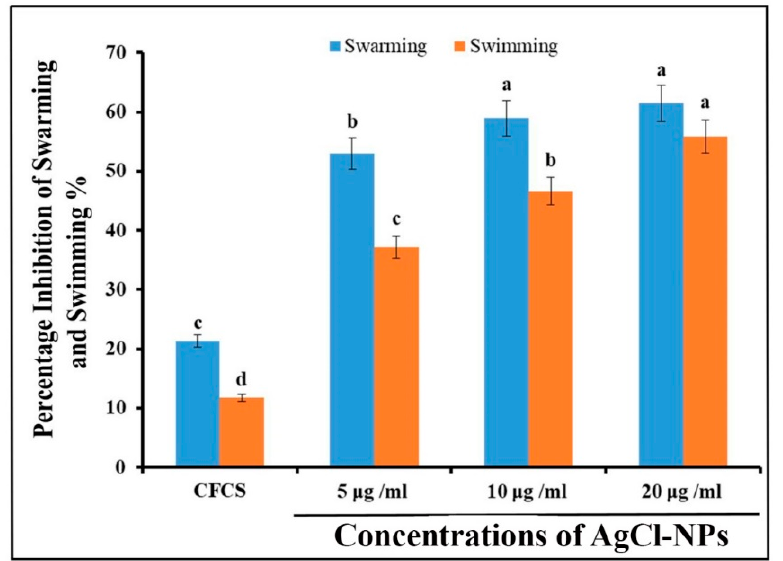
Figure 8. Effect of biosynthesized AgCl-NPs on the motility of R. solanacearum after incubation for 96 h. Vertical bars represent swimming (red color) and swarming (blue color). Vertical bars represent standard errors of the means ( n = 3). The bars with different letters are significantly different ( p < 0.05). CFCS: cell-free culture supernatant.